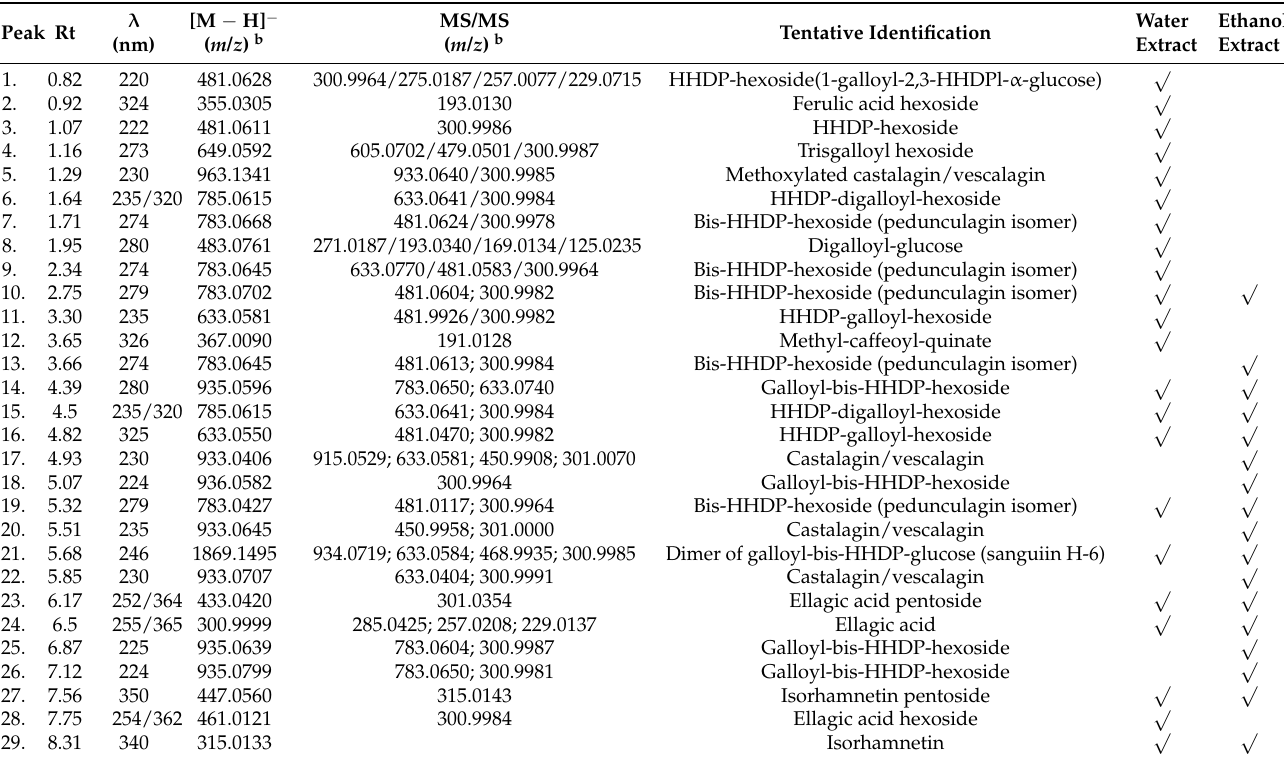
Table 1. Identification of phenolic compounds in Alder acorns a